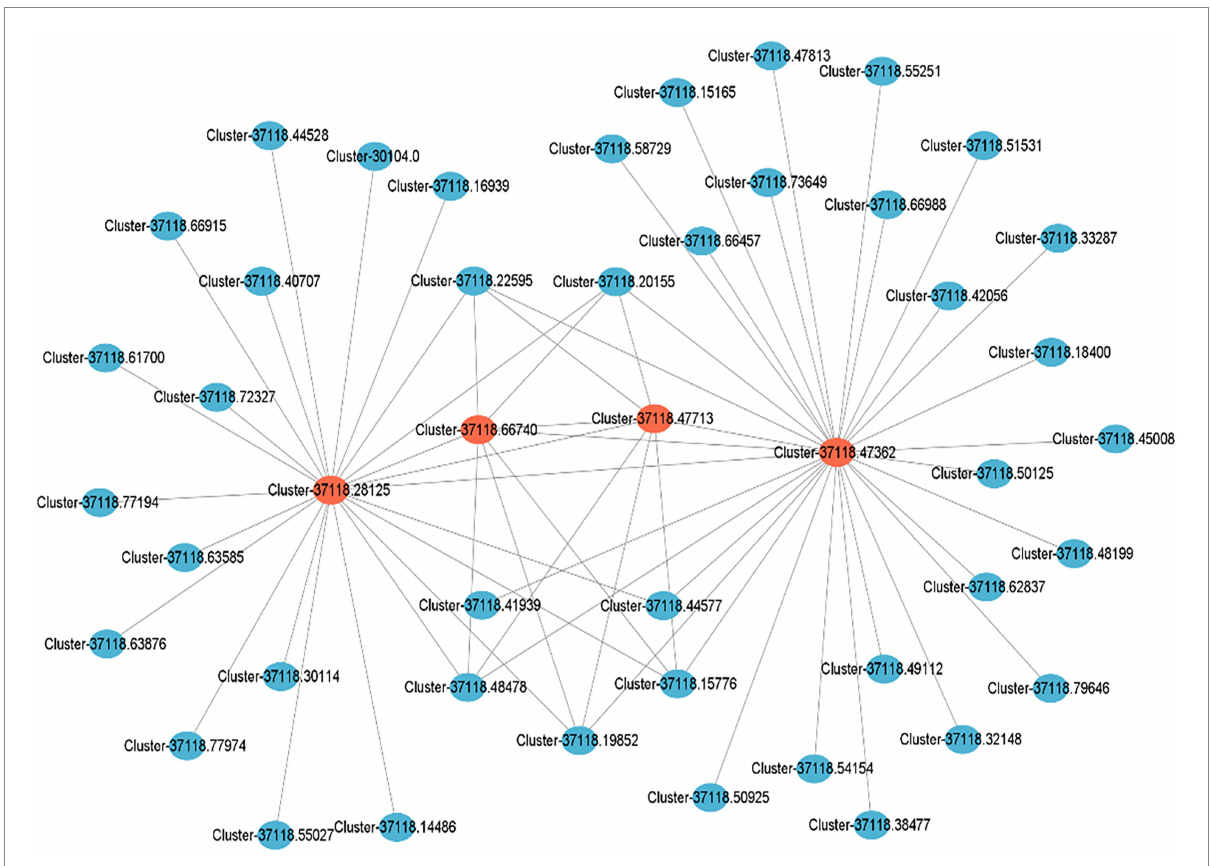
FIGURE 8 Local regulatory network of cold tolerance-related genes obtained from the brown module. Red circles represent the key cold tolerance-related genes, while blue ones represent the differentially expressed genes interacting with the key genes.